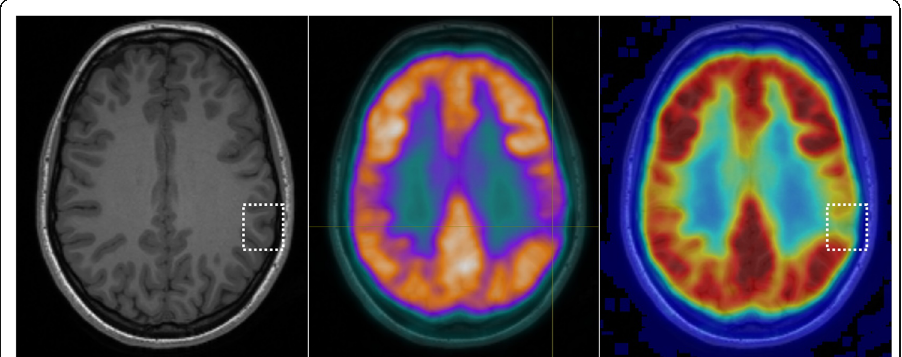
Fig. 3 MRI and PET images for an individual with focal PET hypometabolism enabling detection of a subtle BOSD. MRI was initially negative in this patient, while a focal hypometabolism was detected on PET.